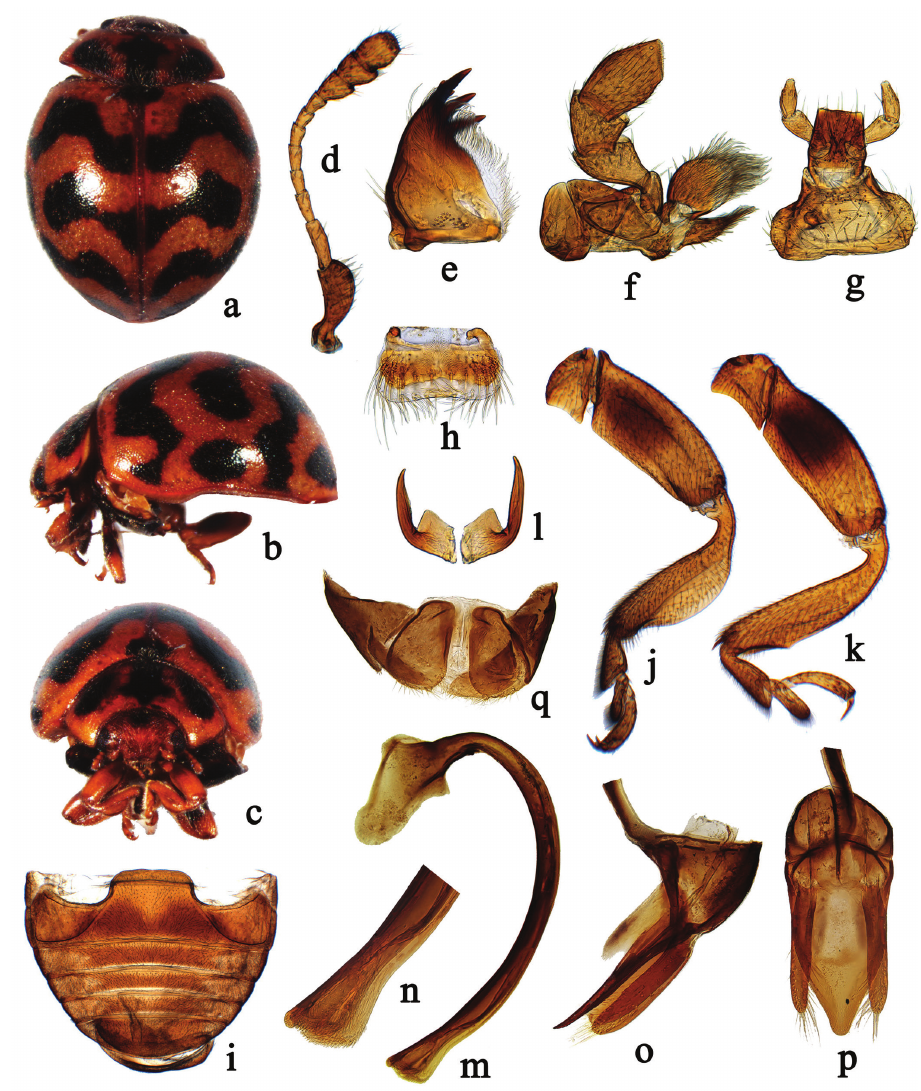
Figure 3. Cynegetis chinensis Wang & Ren, sp. n. a dorsal habitus b lateral habitus c frontal habitus d an- tenna e mandible f maxilla g labium h labrum i abdomen j front leg k hind leg l tarsal claw m–p male genitalia: m penis n apex of penis o tegmen, lateral view p tegmen, ventral view q female genitalia: